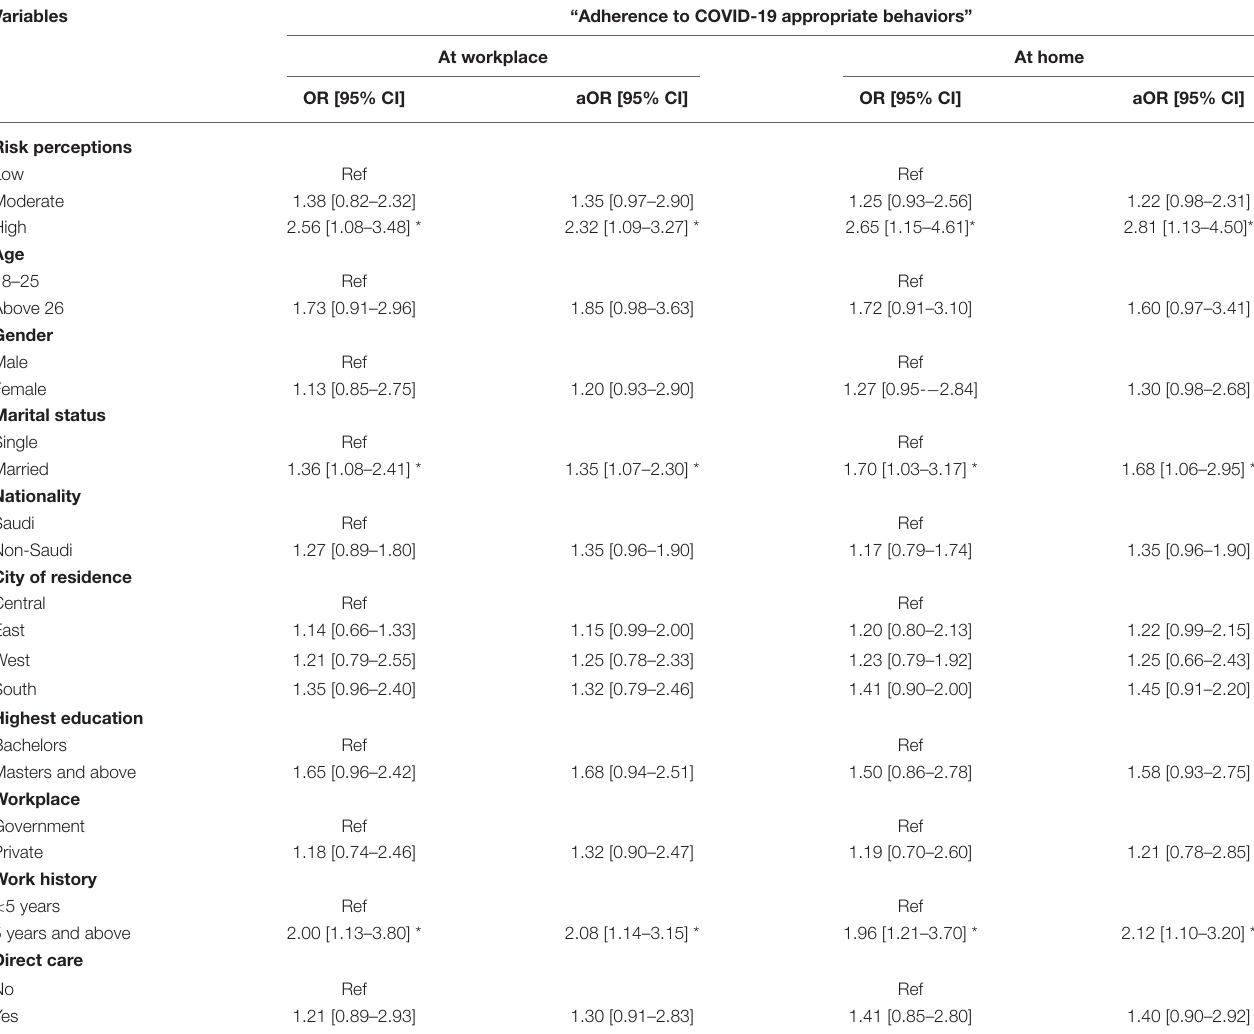
TABLE 4 | Logistic regression analyses for association between appropriate behaviors and socio-demographic characteristics of the study participants ( N = 215).